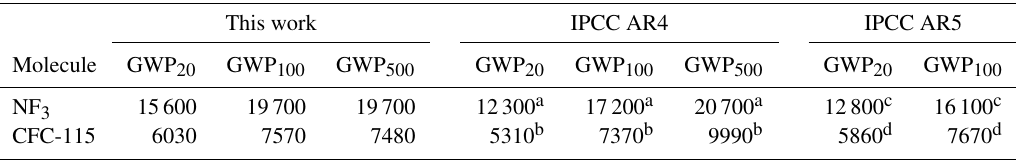
Table 6. Comparison of the 20-, 100- and 500-year global warming potentials for NF 3 and CFC-115 from this work, the IPCC AR4 (Forster et al., 2007) and the IPCC AR5 (Myhre et al., 2013). This work IPCC AR4 IPCC AR5 Molecule GWP 20 GWP 100 GWP 500 GWP 20 GWP